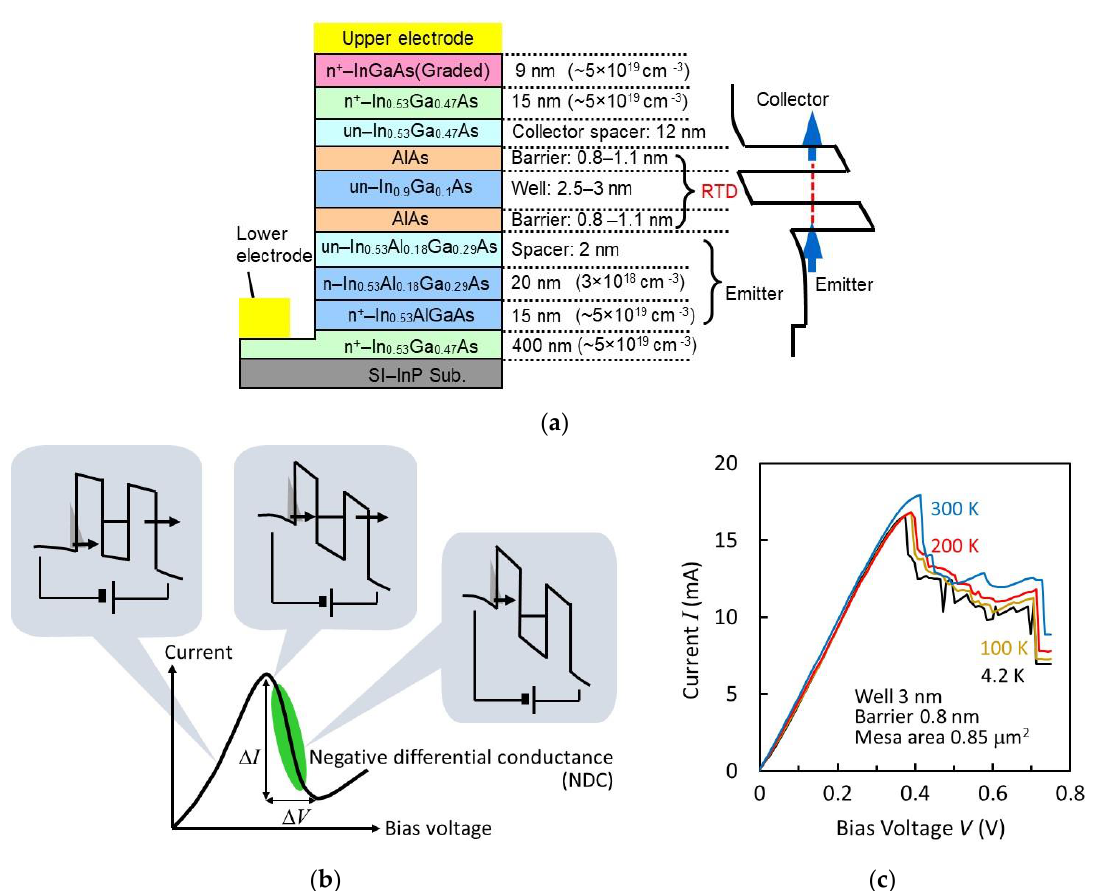
Figure 2. Layer structure and current–voltage characteristics of resonant-tunneling diodes (RTDs): ( a ) Layer structure of InGaAs/AlAs double-barrier RTD. Reprinted with permission from [56]. Copyright (2016) Springer Nature. ( b ) Schematic I–V curve and potential profile at various bias voltages, and ( c ) an example of measured I–V curves at various temperatures [52].